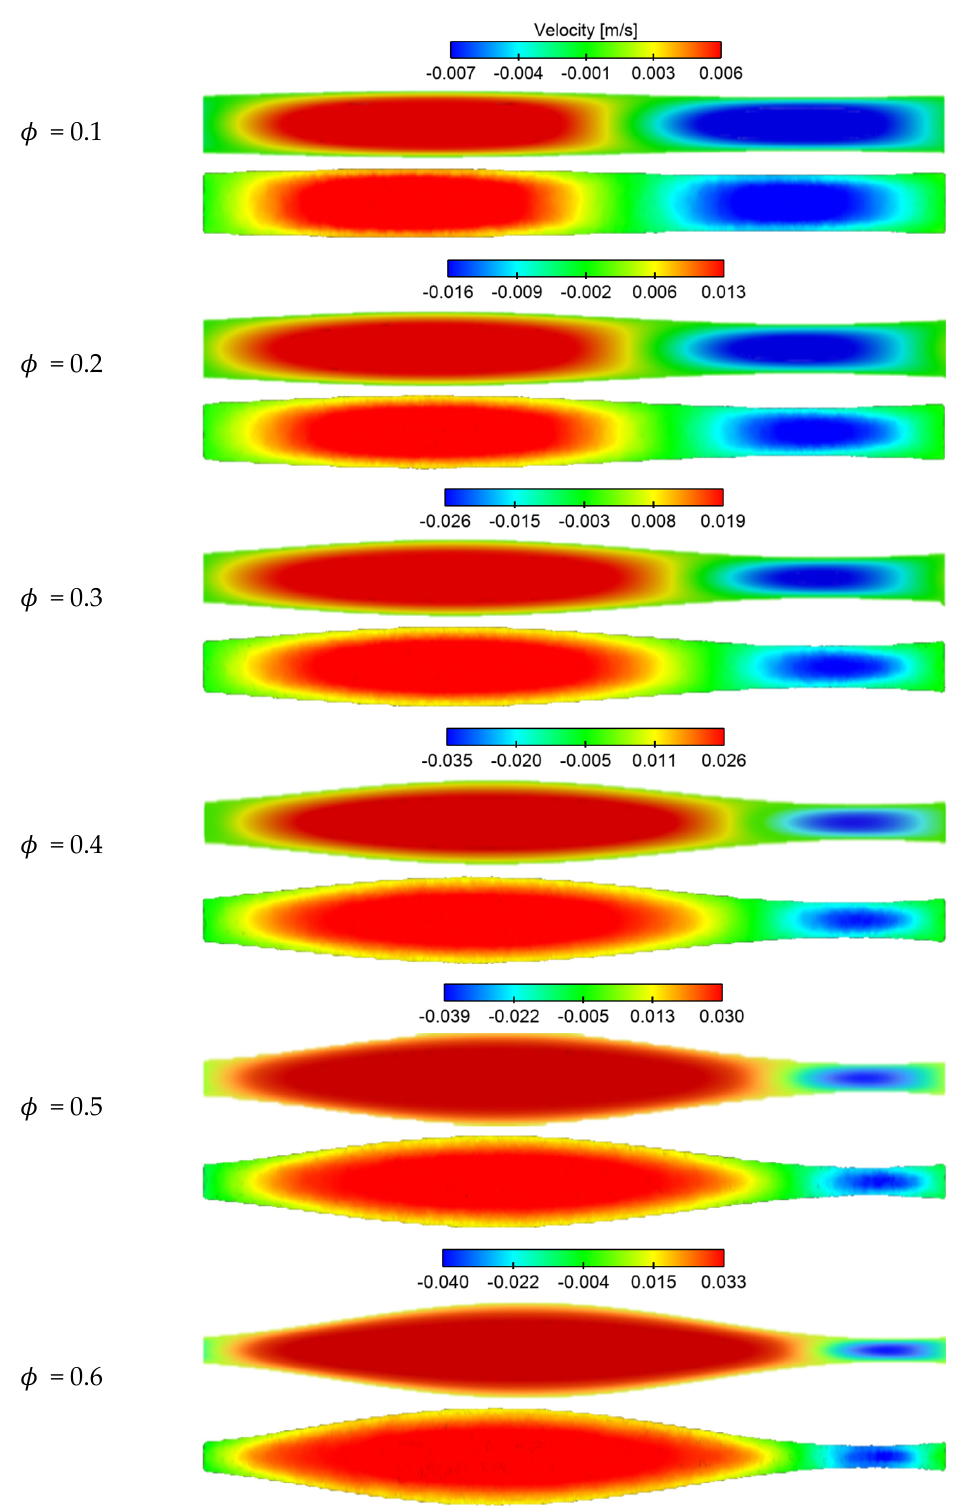
Figure 7. Axial velocity contours at 5 s from the FVM model (top) and the SPH model (bottom).